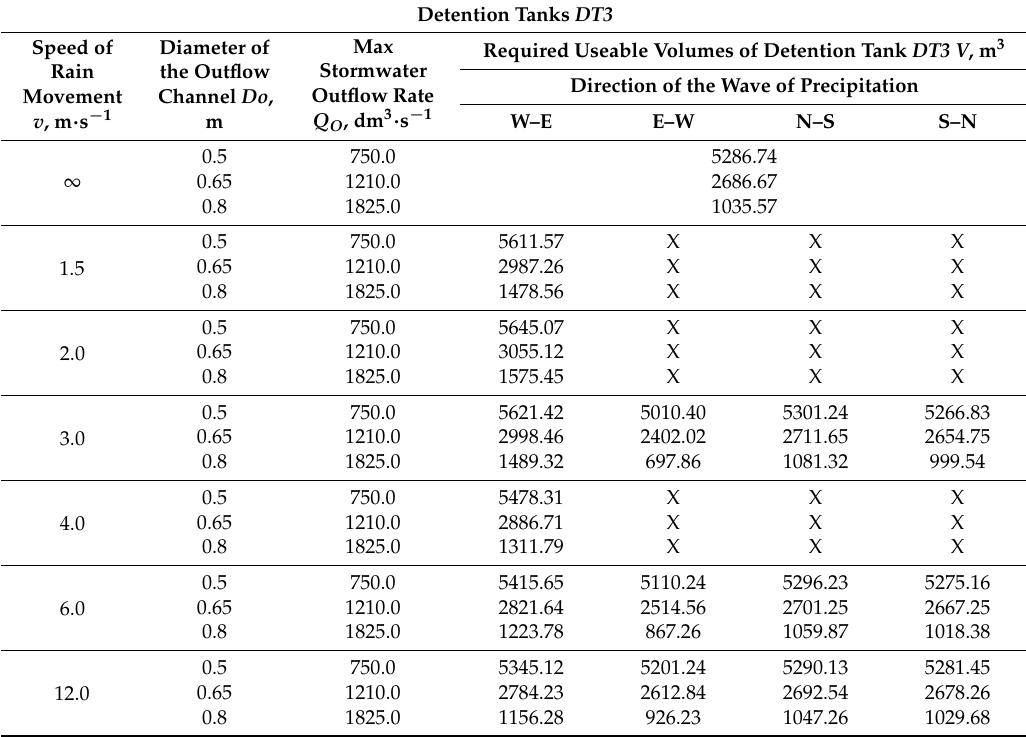
Table 4. Required volumes of detention tanks DT3 determined at the specific diameter of the outflow channels from reservoirs DT1 and DT2 , D O = 0.5 m.